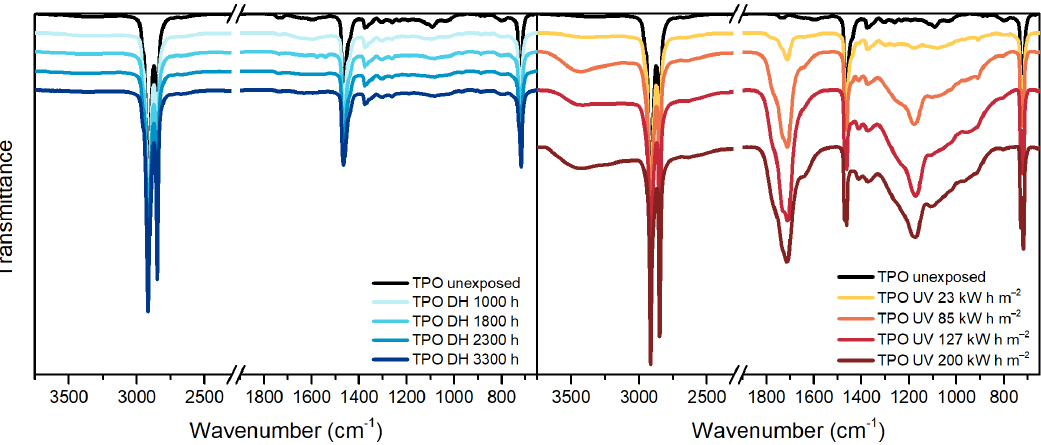
Figure 5. FT-IR ATR Spectroscopy measurements of TPO samples before and after exposure to DH ( left ) and UV test ( right ).